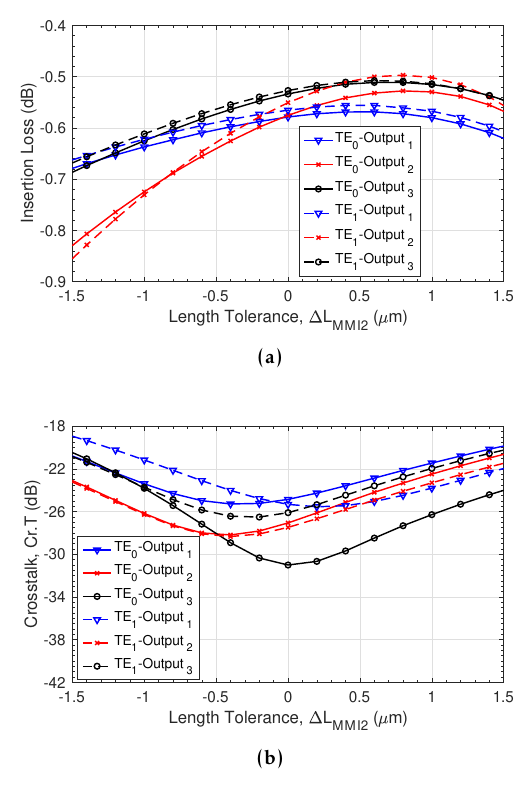
Figure 10. Insertion loss (a) and crosstalk (b) of the proposed switch as a function of the length tolerance of MMI